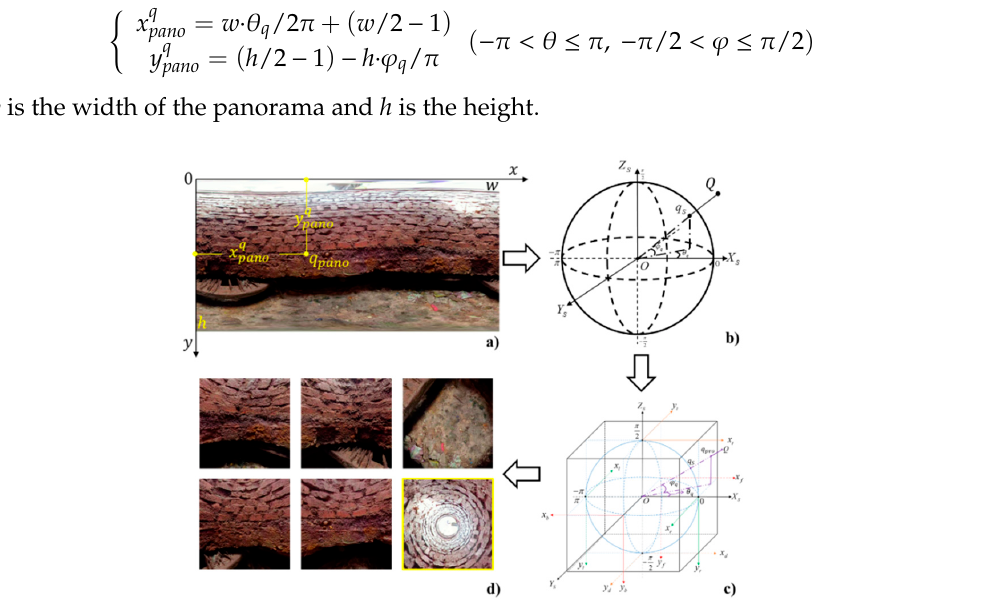
Figure 3. Panorama reprojection strategy: original panorama ( a ), panoramic sphere ( b ), reprojection directions ( c ), and reprojectedresults ( d ).